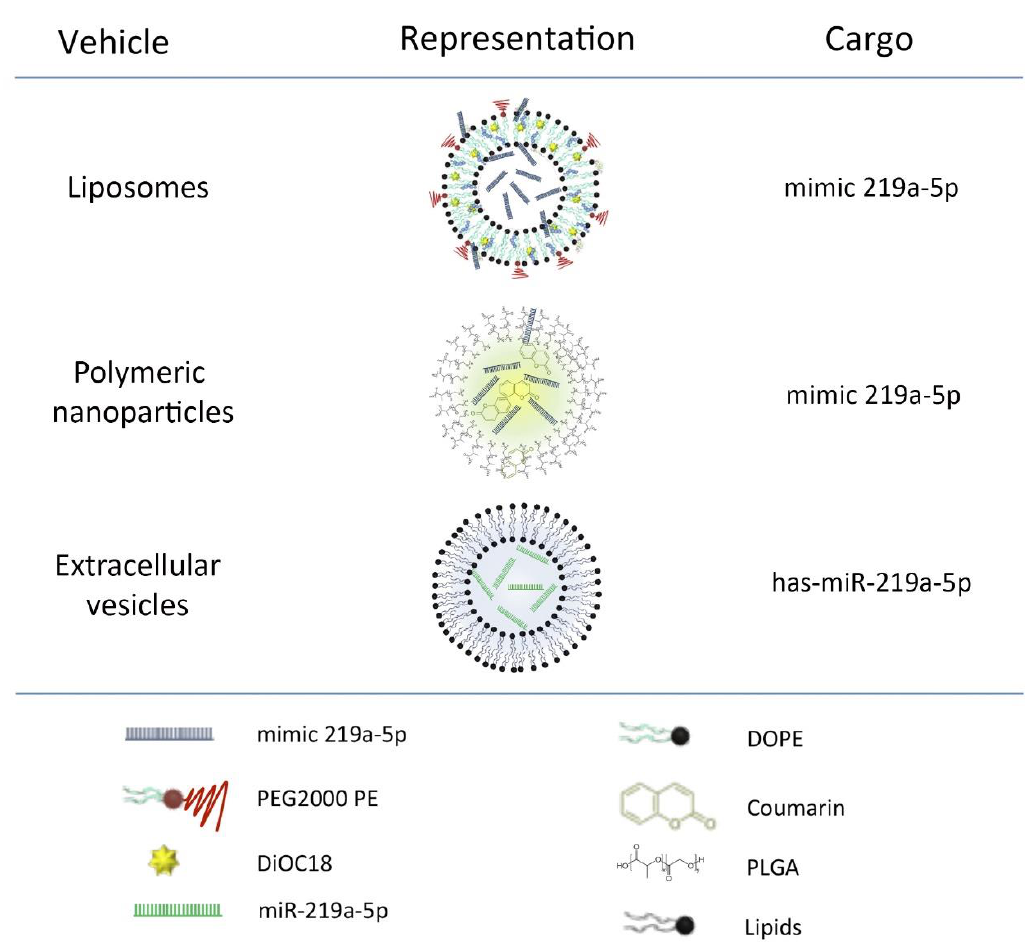
Figure 1. Schematic representation of liposomes, polymeric nanoparticles and extracellular vesicles. Carriers with their main components and the type of miR219a-5p they were loaded with. Liposomes and polymeric nanoparticles were loaded with synthetic microRNA. In contrast, extracellular vesicles (EVs) contained biologically produced microRNA. Polymeric nanoparticles and liposomes were also loaded with a dye (coumarin and DiOC18, respectively) to perform up-take